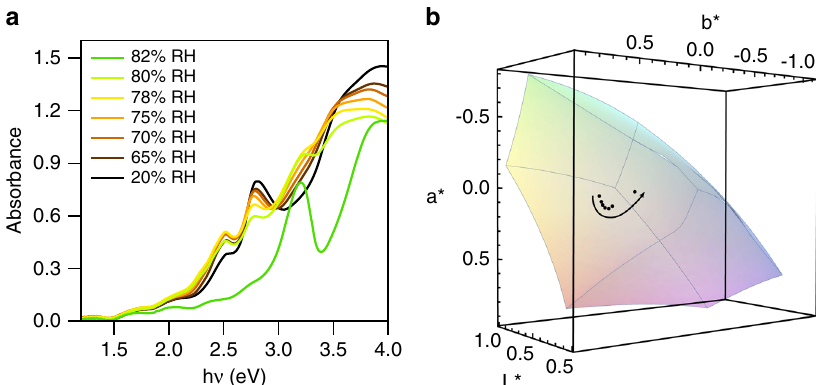
Fig. 5 Color of hygrochromic fi lms. a Absorbance and b Color of FA n + 1 Pb n I 3n + 1 composite fi lms plotted in CIE 1976 L*a*b* coordinate space. Film color is calculated from absorbance spectra in ( a ). The colored polyhedron in b is a visualization of the sRGB gamut used in displays and digital photography. The arrow in b shows the direction of increasing relative humidity